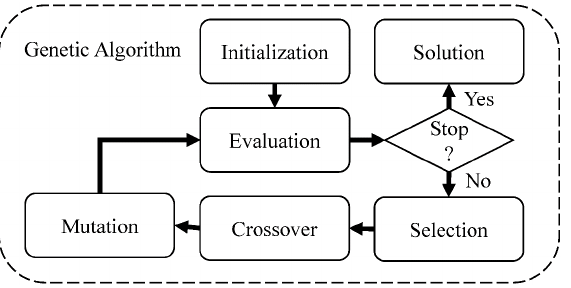
Figure 5. Flow chart for genetic algorithm.